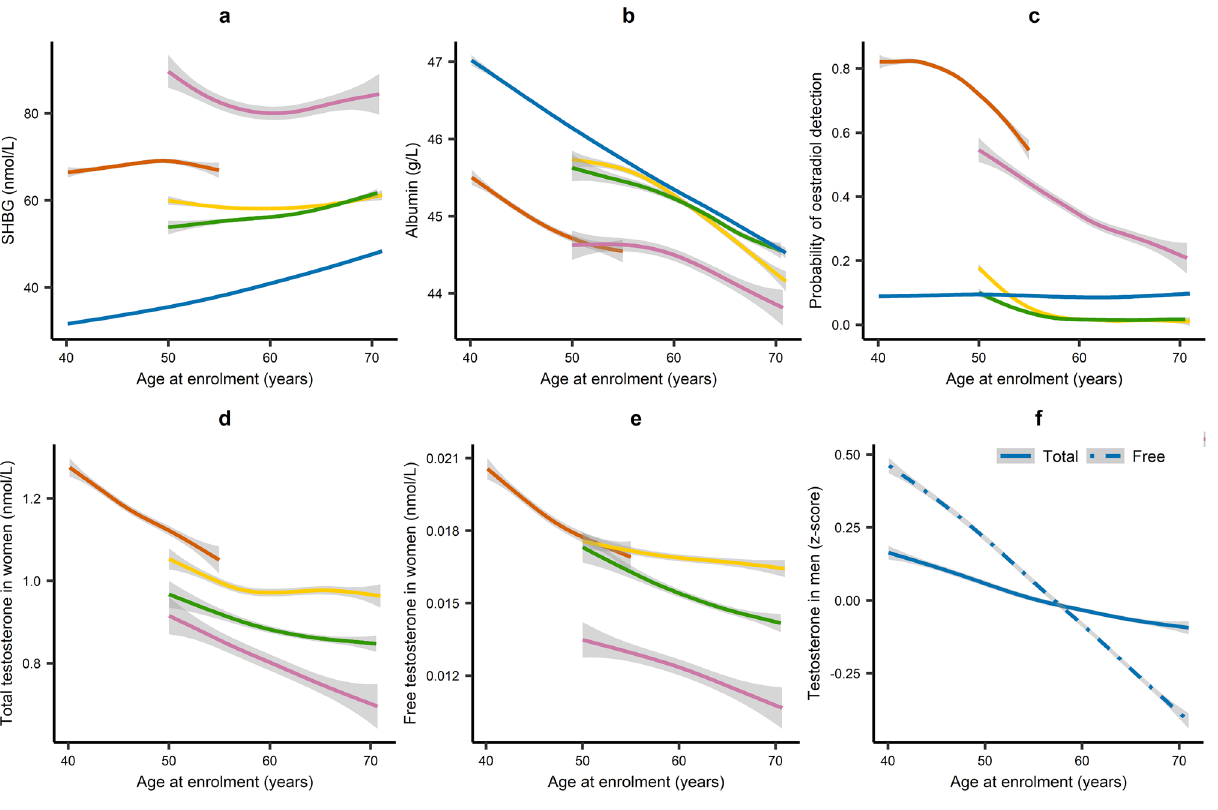
Figure 1. Sex steroids and their binding proteins according to age at enrolment. HRT hormone replacement therapy, Post-MP post-menopausal, Pre-MP pre-menopausal, SHBG sex hormone binding globulin, z-score value minus mean divided by standard deviation, sex specific. Plots represent means of unadjusted levels (95% confidence interval), determined with the generalised additive models smoothing function from package mgcv, with restricted maximum likelihood (REML) estimation, applied as default for large datasets in ggplot2 v.3.3.5 in R v4.1.0. Participant groups are defined in Supplementary Fig. S1. Estimates for associations with age obtained from fully adjusted multivariable models are shown in Supplementary Table